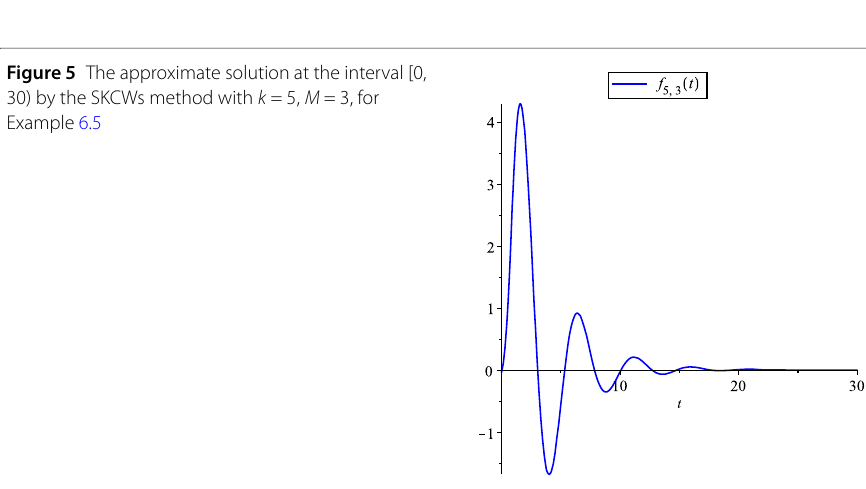
Figure 4 Graphs of the obtained results at the interval [0,10) by the SFOJPs method with N = 8, λ = 1 ϑ = 3, for Example 6.4